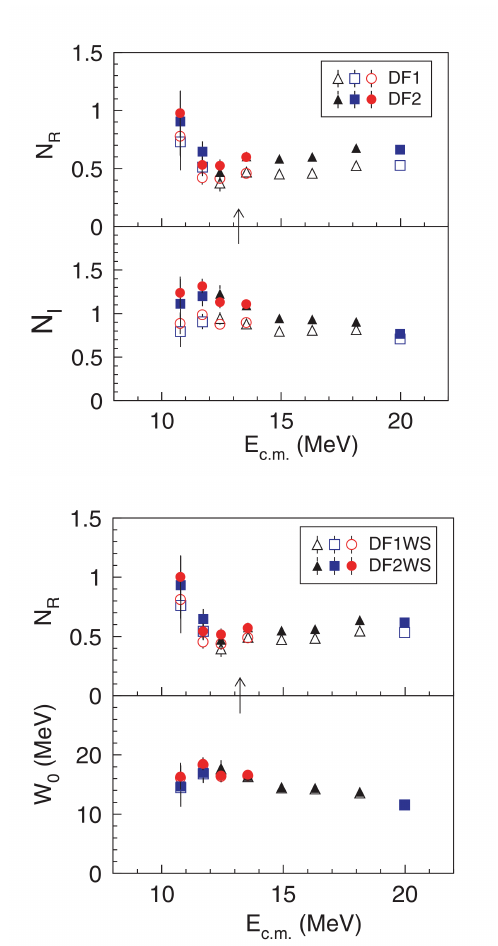
Fig. 4. Trend of the optical model potential obtained by fitting the elastic scattering angular distributions with two di (cid:11) erent po- tentials from [8]. Renormalized double folding potential for both real and imaginary part (DF1); renormalized double folding po- tential for the real part and Woods-Saxon potential for the imagi- nary part (DF1WS, DF2WS). See the text for